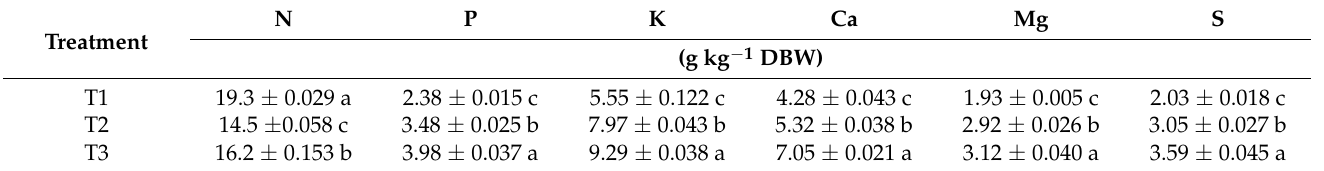
Table 4. Macronutrient concentrations in root tissues of lulo ( Solanum quitoense Lam.) seedlings grown in substrates containing different percentages ( v / v ) of peatmoss and compost under green- house